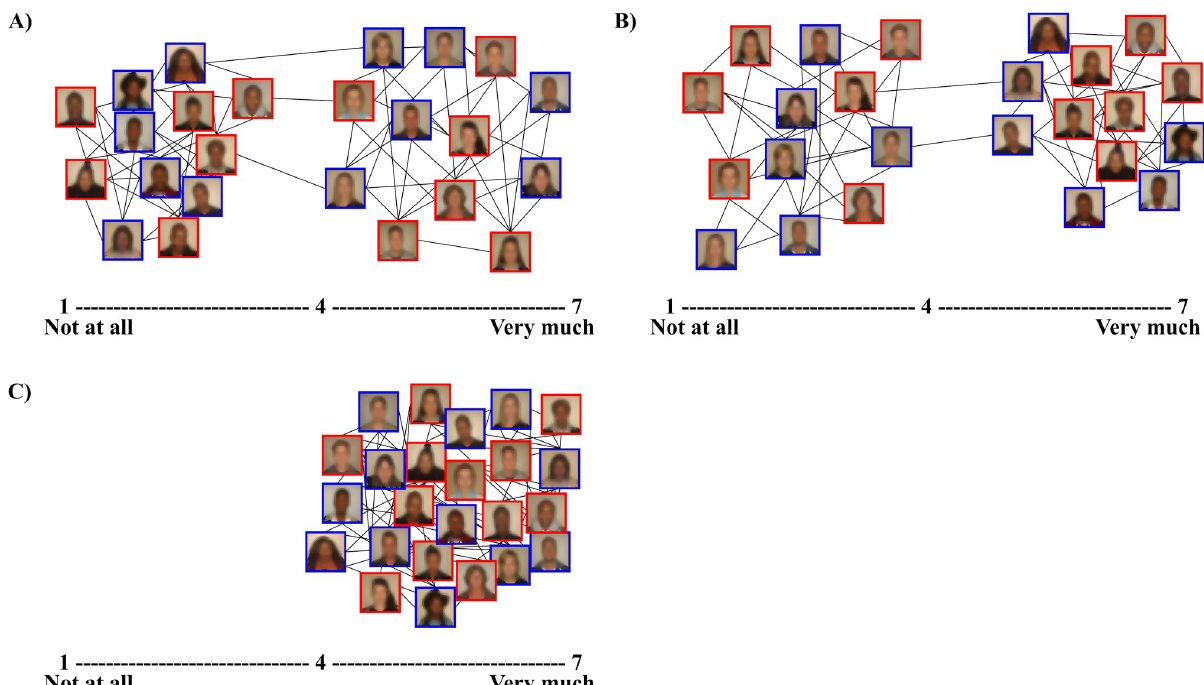
Fig 2. Sample diagrams of the racial political salience manipulation. A) The diagram indicated that White team members were largely in support of a petition that urged parliament to revoke a progressive policy that would benefit historically disadvantaged groups. B) The diagram indicated that Black African team members were largely in support of petitions that urged parliament to implement aggressive policies at the expensive of previously advantaged White people. C) The diagram indicated broad support from all team members towards arbitrary petitions about general campus matters. Note . None of the individuals in these images participated in the current